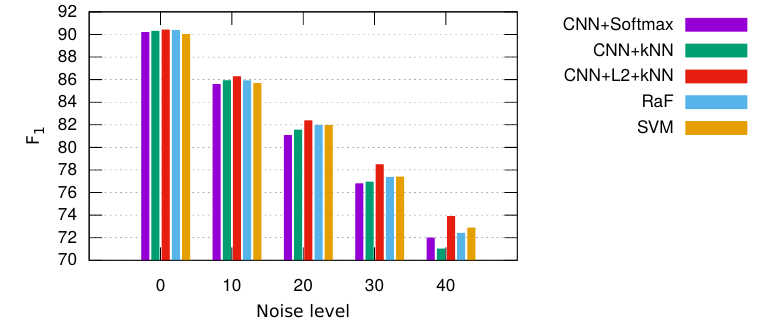
Figure 4. Average F 1 (%) accuracy ( y -axis) with respect to the noise level ( x -axis) considering several supervised classification schemes. RaF, Random